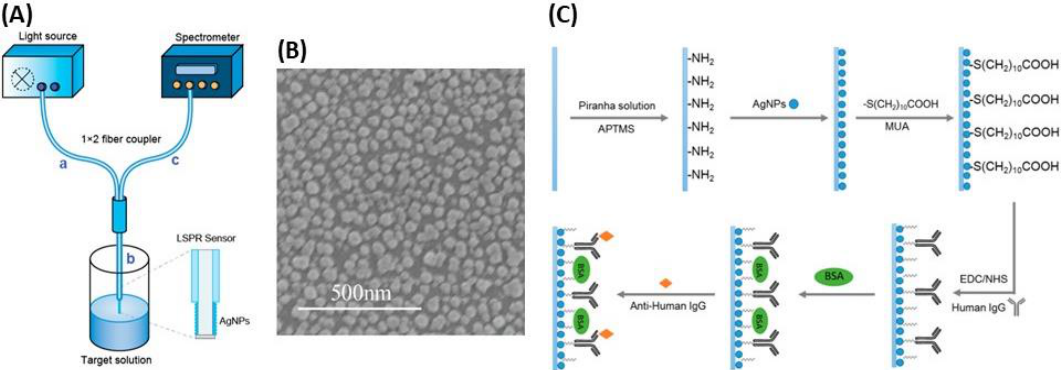
Figure 23. ( A ) Schematic illustration of the experimental set-up used for the LSPR optical fiber sensor. ( B ) SEM image of immobilized AgNPs on optical fiber surface. ( C ) Illustration of the employed strategy for the development of LSPR optical fiber biosensors based on AgNPs. Adapted from [179].